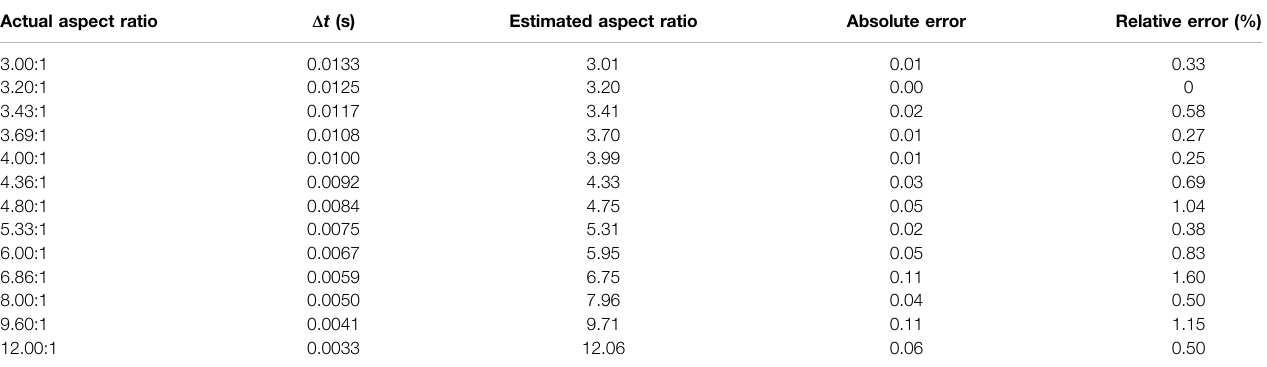
TABLE 3 | Estimation results of the aspect ratio. Actual aspect ratio Δ t (s) Estimated aspect ratio Absolute